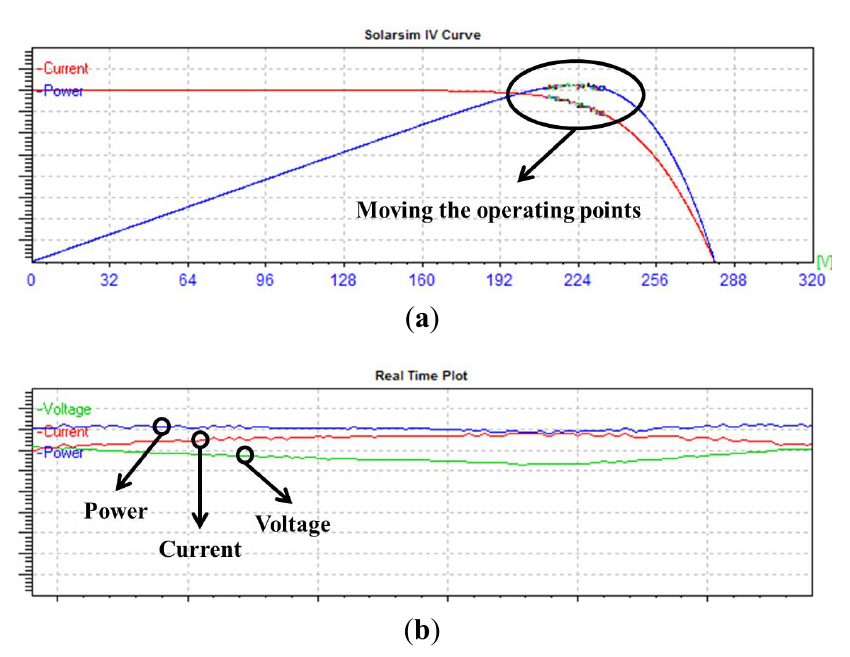
Figure 25. Operating points of PV array before compensation. ( a ) P-V and I-V curve; ( b ) real-time plot.